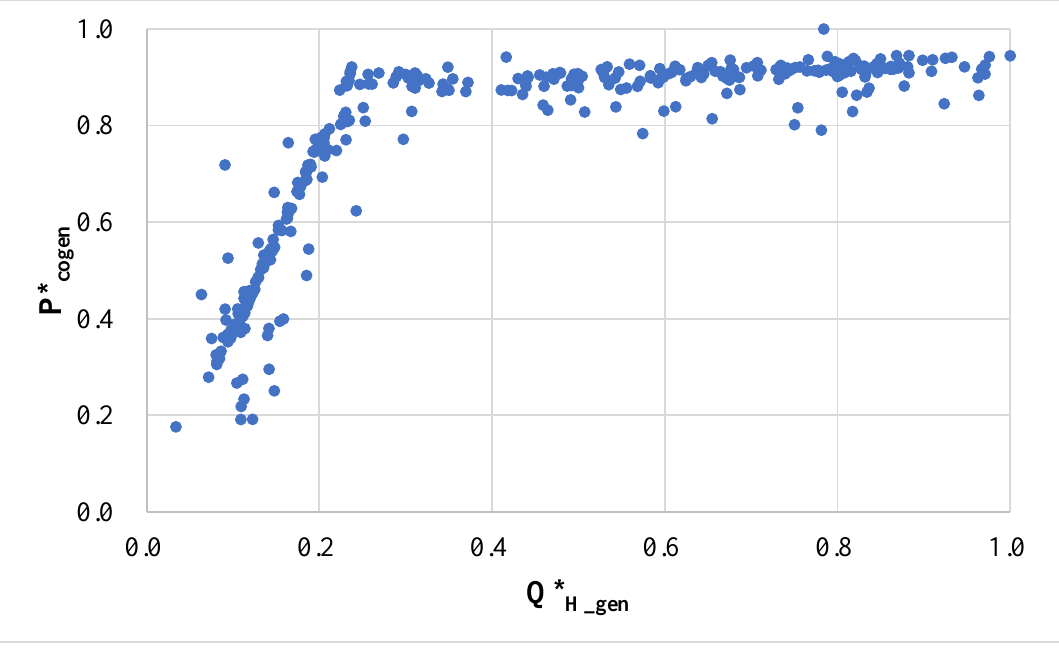
Figure 11. Relationship between the key operational parameters for annual operation events in Case A.